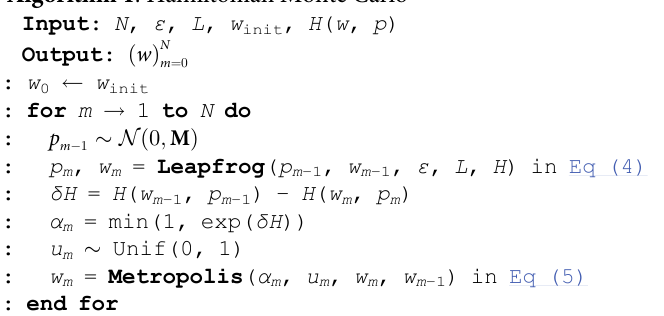
Algorithm 1 : Hamiltonian Monte